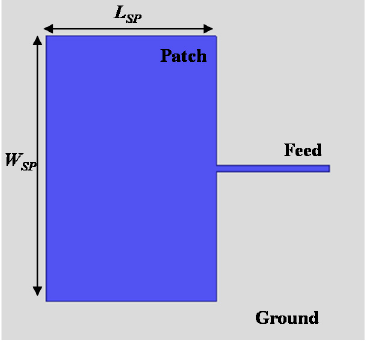
Figure 1. Top view of THz on-chip patch antenna.